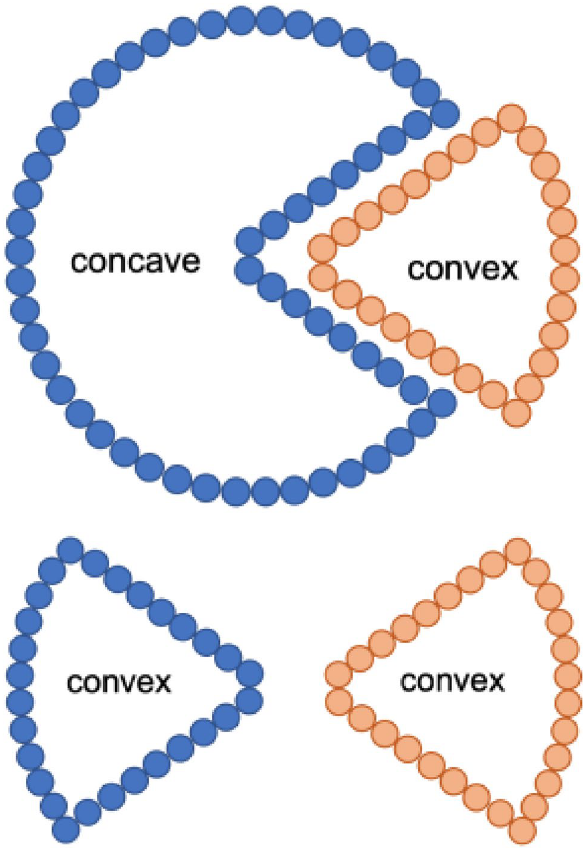
Figure 11. Atoms in convex and concave shapes at the surface curvature. The figure at the top shows a matched concave-convex pair, thus a strong interaction, while the figure at the bottom shows an unmatched pair and a weak